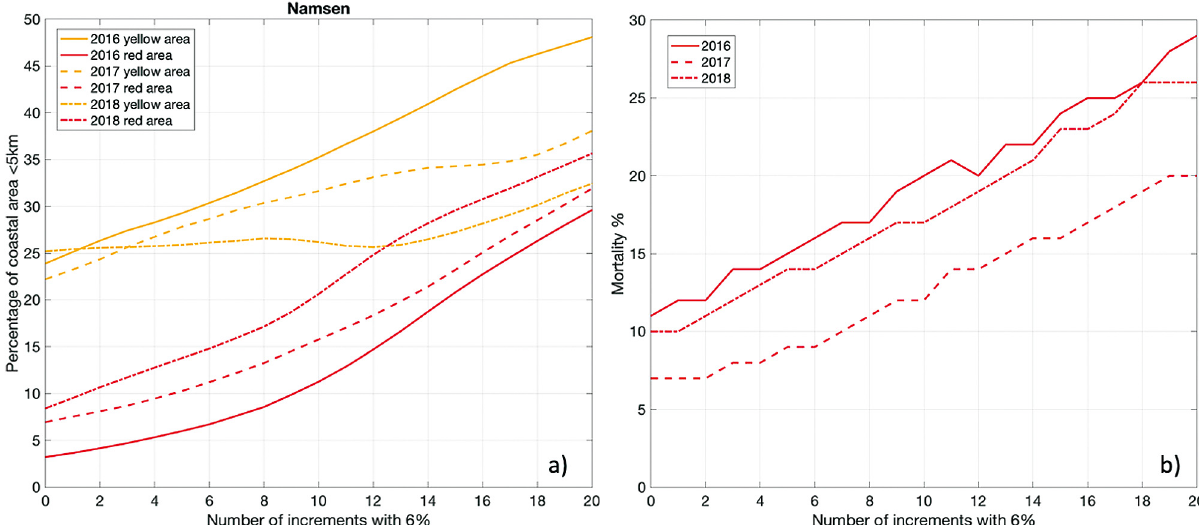
Fig. 6. (a) Total percentage of red and yellow areas in the entire production zone (within 5 km from the coast) as a function of 6% increments in salmon production, comparing the 3 reference years (2016, 2017 and 2018). (b) Modeled mortality from the virtual post-smolt model when they reached 20 km from the nearest land point with constant lice releases in the 3 different physical